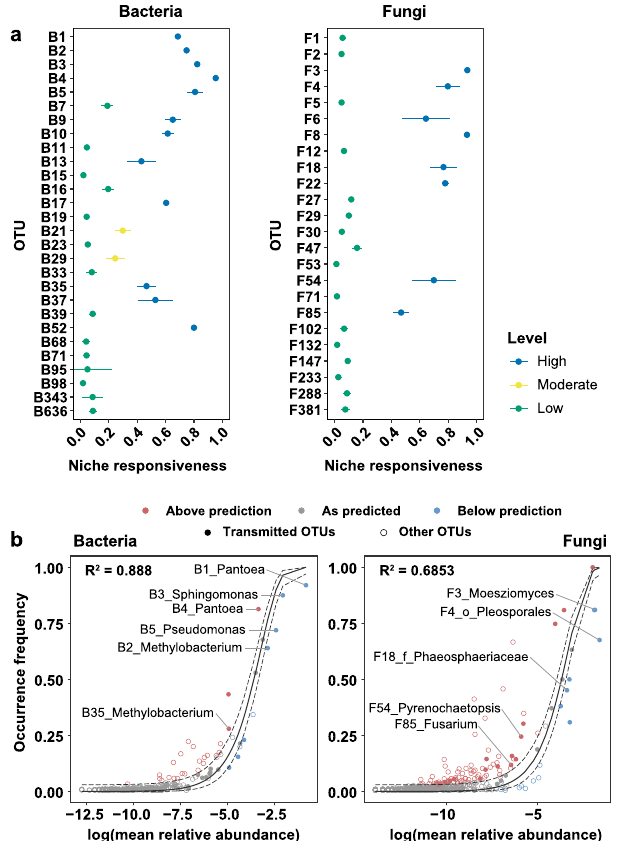
Fig. 3 Heritability and neutral process in the formation of seed microbial community. a Heritability estimates for vertically transmitted bacterial and fungal OTUs. Dots and error bars indicate mean heritability estimates and standard deviations from bootstrapped data (number of simulations = 100). Dots are colored by levels of estimates (High, h 2 > 0.4; Moderate, 0.2 < h 2 ≤ 0.4; Low, h 2 ≤ 0.2). b Sloan ’ s neutral model for seed bacterial and fungal communities. Each dot indicates OTUs in the bacterial and fungal communities. The predicted neutral model (solid black line) is surrounded by 95% con fi dence intervals (dashed lines). The frequency of occurrence of bacterial and fungal OTUs during seed development ( y -axis) is plotted against OTU ’ s relative abundance ( x -axis) to indicate that the OTU is most likely neutrally distributed (gray dots) or selected (red and blue dots). Filled dots correspond to the vertically transmitted bacterial and fungal OTUs, whereas hollow dots denote other seed OTUs. The names of bacterial and fungal OTUs indicate the OTUs commonly predicted to be affected by niche process using heritability (niche responsiveness) analyses and Sloan ’ s neutral